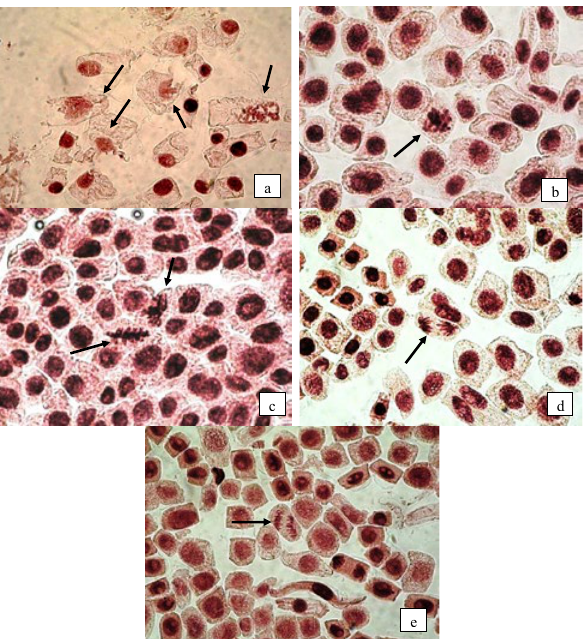
Fig. 1. a: membrane and nucleus deformation in solvent control (cit- ric acid) group; b: stickiness; c: stickiness and polar deviation in pos- itive control group; d: polar deviation in 20 µg/ml fulvic acid treat- ment group; e: polar deviation 80 µg/ml fulvic acid treatment